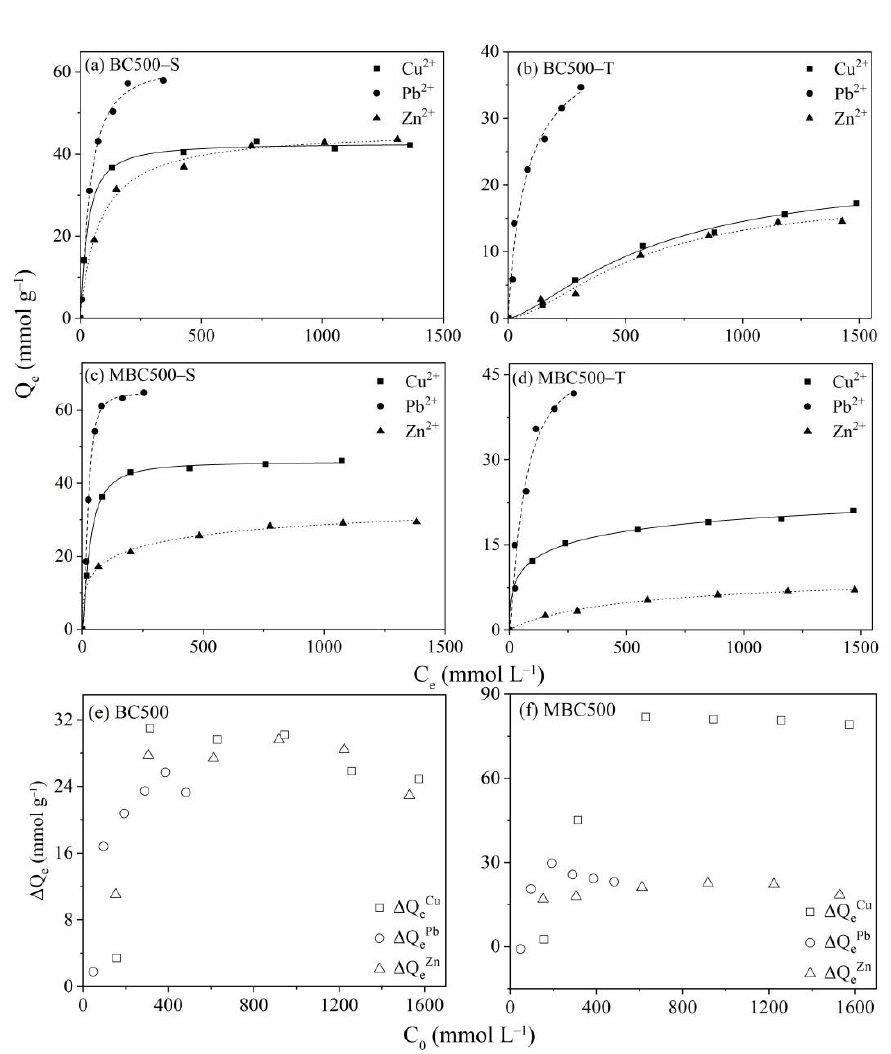
Figure 4. Competitive adsorption of Cu 2+ , Pb 2+ , and Zn 2+ (S: single metal adsorption ( a , c ); T: ternary metal adsorption ( b , d ); Q eCu , Q ePb and Q eZn represent the adsorption capacity of Cu 2+ , Pb 2+ and Zn 2+ in ternary-metal system, respectively; ∆ Q eCu , ∆ Q ePb , and ∆ Q eZn represent the ∆ Q e of Cu 2+ , Pb 2+ , and Zn 2+ in ternary metal systems, respectively ( e , f )). For BC500, the Q m of Cu 2+ , Pb 2+ , and Zn 2+ decreased from 42.66 to 21.58 mmol g −